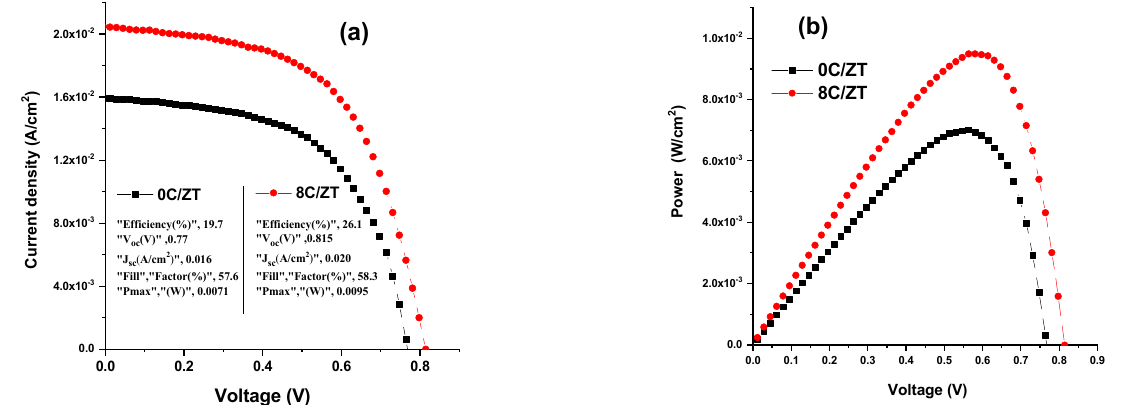
Figure 16. The basic structure of the glass/ITO/CdS/ZnTe/ZnTe:Cu/CdTe/metal thin-film solar cell diagram.